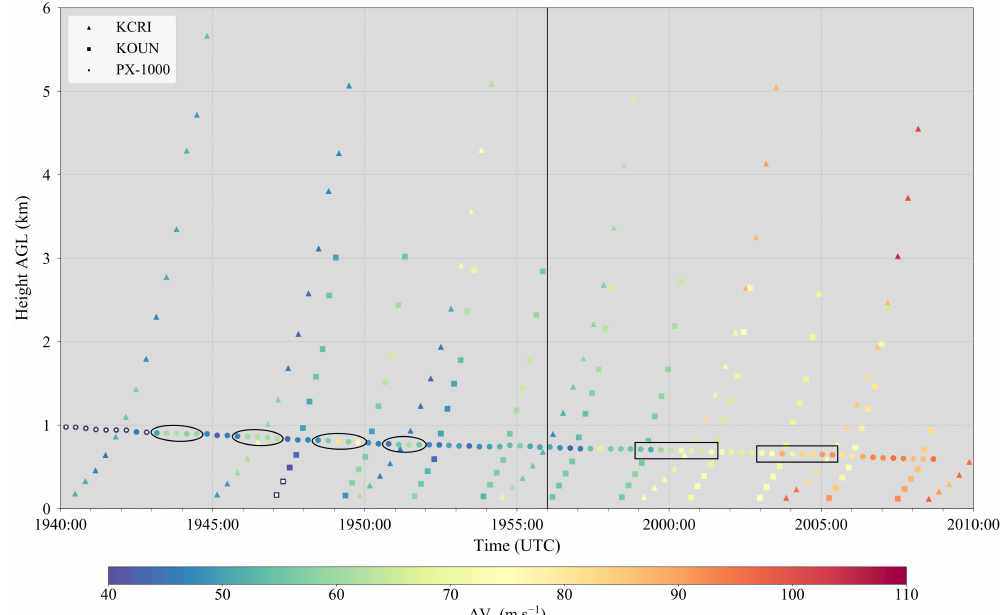
Figure 4. Time series of time-height corrected ∆ V r plotted above ground level (AGL) for PX-1000 (circles), KCRI (triangles), and KOUN (squares). The color bar comprises the spectrum of tornadic intensity seen on 20 May 2013, with subtornadic intensity ( ∆ V r below 40 ms − 1 ) depicted as white markers outlined in black. The solid black vertical line denotes the time of tornadogenesis at ∼ 1956 UTC. The solid black ovals prior to tornadogenesis mark the four periods of transient intensifica- tions of the low-level mesocyclone (LLM), as captured by PX-1000, while the solid black rectangles after tornadogenesis signify the two periods of rapid